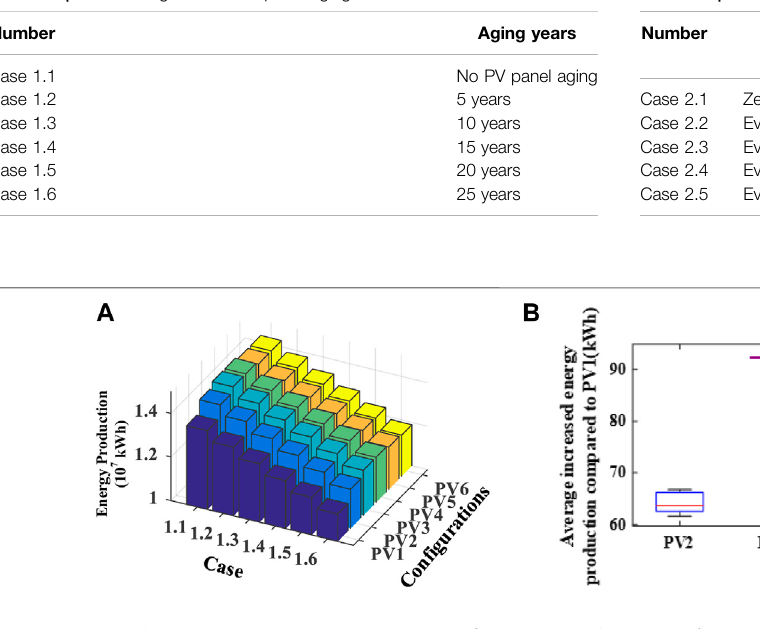
PV Panel Aging: Assuming that all the PV panels in the PV plant are placed at the same azimuth of zero and there is no cloud